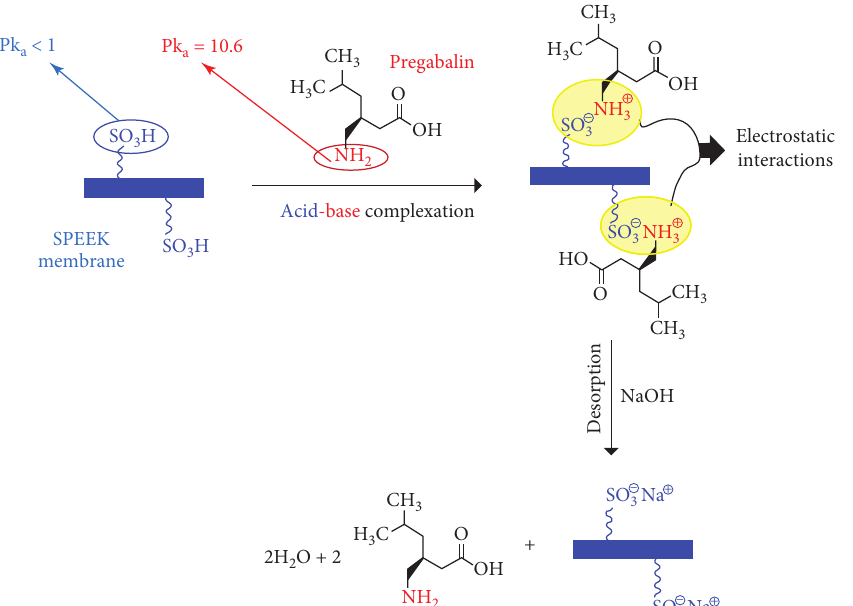
Figure 2: Illustration for the ion-exchange mechanism and the electrostatic interactions between the SPEEK membrane and pregabalin